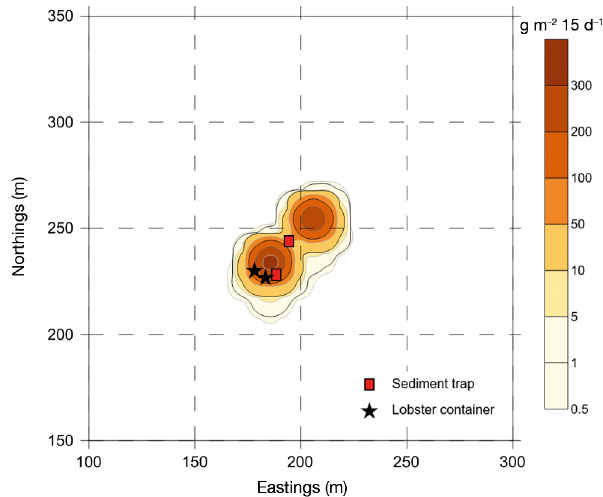
Fig. 2. Contour plot of suspended solids settlement (g m −2 15 d –1 ) around cages 1 and 2, presented as output from a spreadsheet-based dispersion model